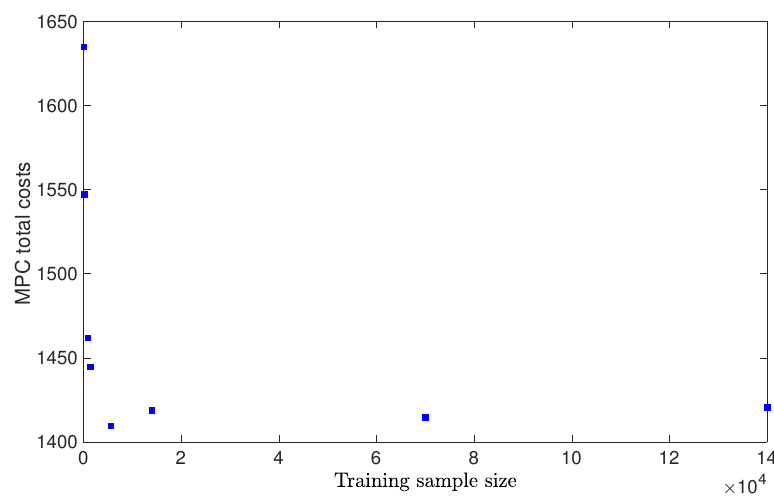
Figure 10. MPC total costs vs. training sample